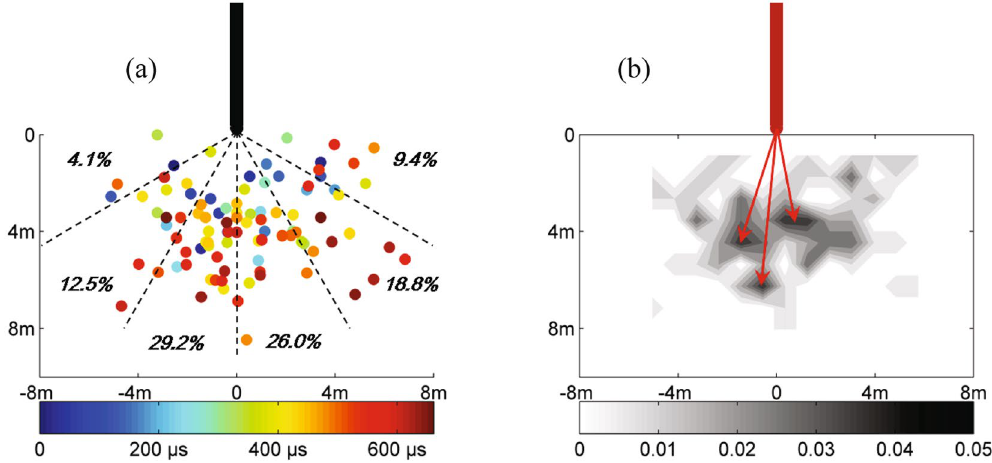
Figure 6. ( a ) Scatter plot showing the locations of each individual steps with the distance and relative direction from the channel tip, ( b ) probability density distribution of the